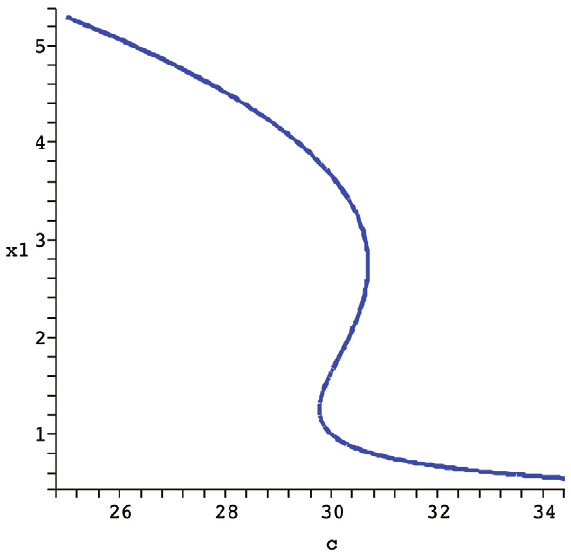
doi:10.1371/journal.pone.0010823.g003